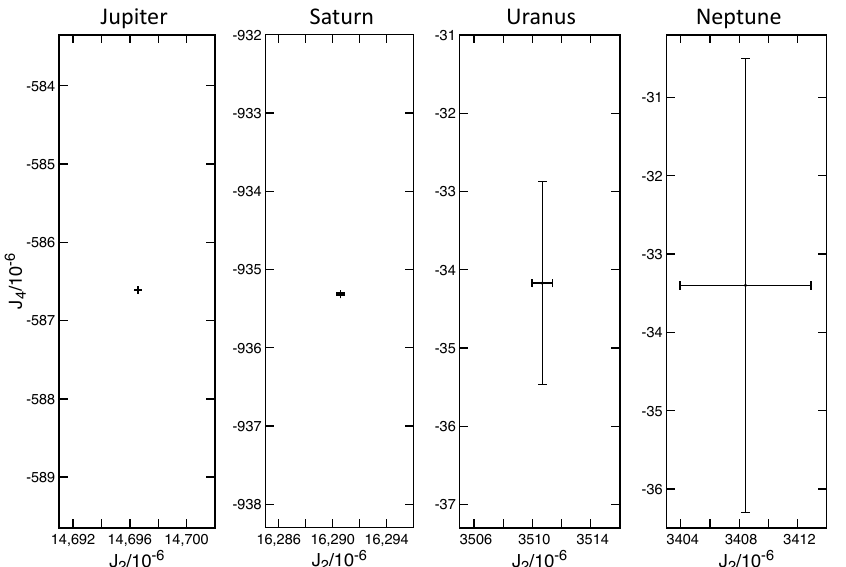
Figure 3. Gravitational harmonics J 2 vs. J 4 for all the giant planets in the solar system (see Table 1 for references). Different figures show the same range in the parameter space to compare the extent of the error bars among the planets.